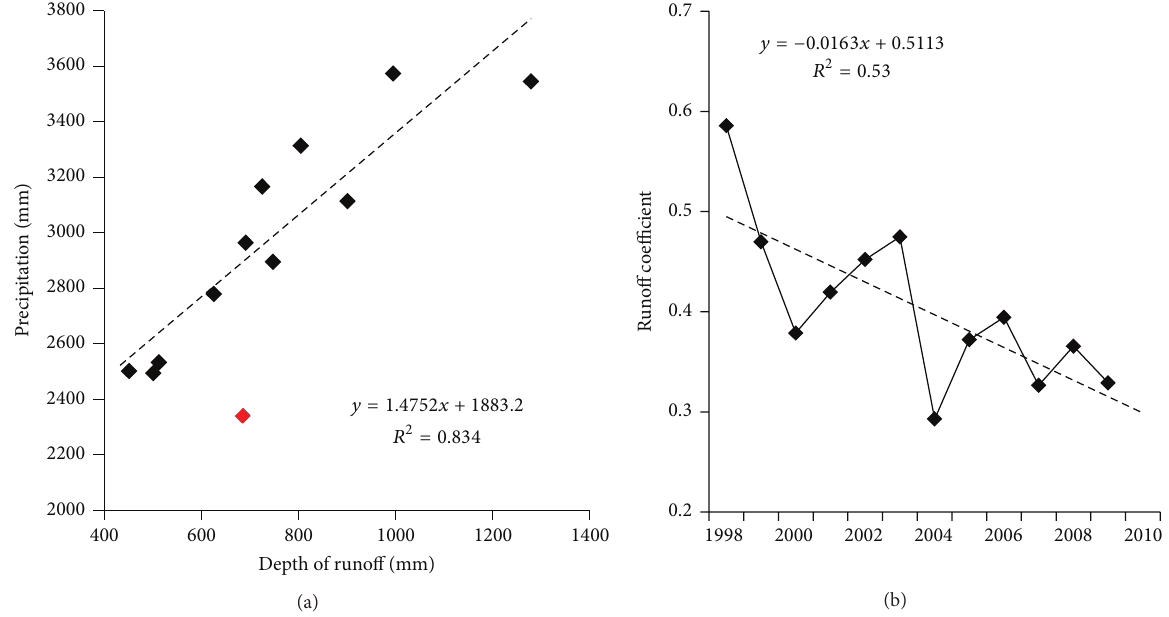
Figure 3: (a) Correlation between annual precipitation and depth of runoff (the red dot shows the data in 2003). (b) The runoff coefficient of variation during 2003–2009.